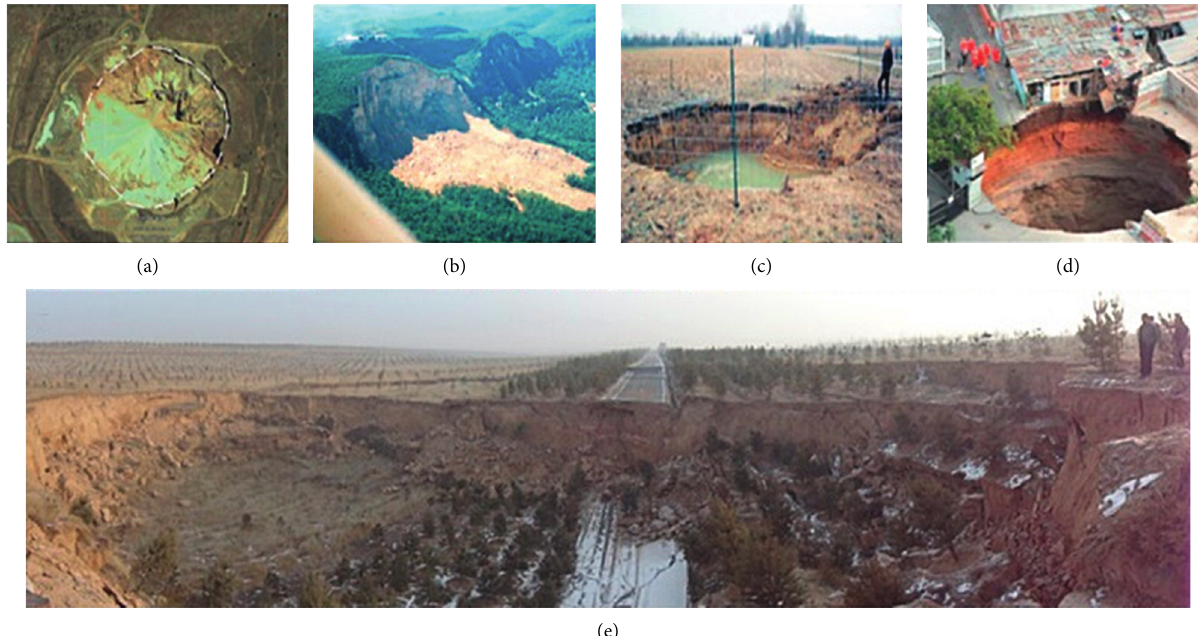
Figure 1: Problems caused by surface subsidence and surface cracks. (a) Surface subsidence in Australia; (b) landslide in Australia; (c) damage to farmland in India; (d) damage to roads in